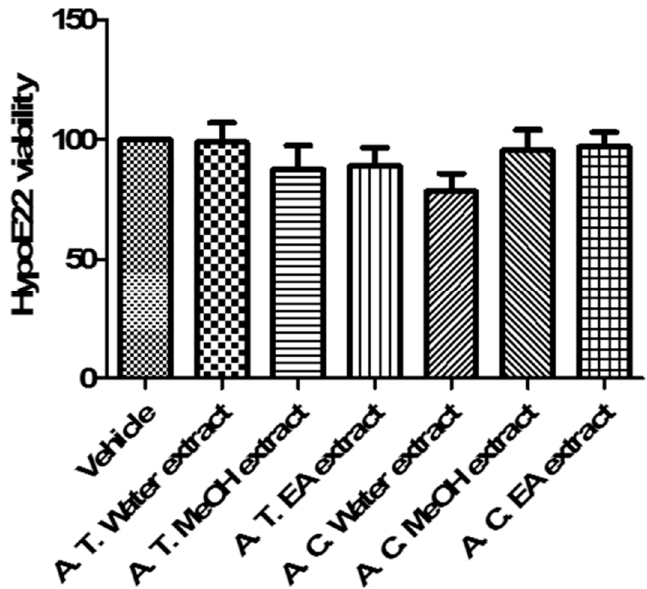
Figure 4. E ff ect of A. tinctoria (A. T.) and A. cretica (A. C.) extracts (100 µ g / mL) on HypoE22 cell Figure 4. Effect of A. tinctoria (A. T.) and A. cretica (A. C.) extracts (100 µg/mL) on HypoE22 cell line